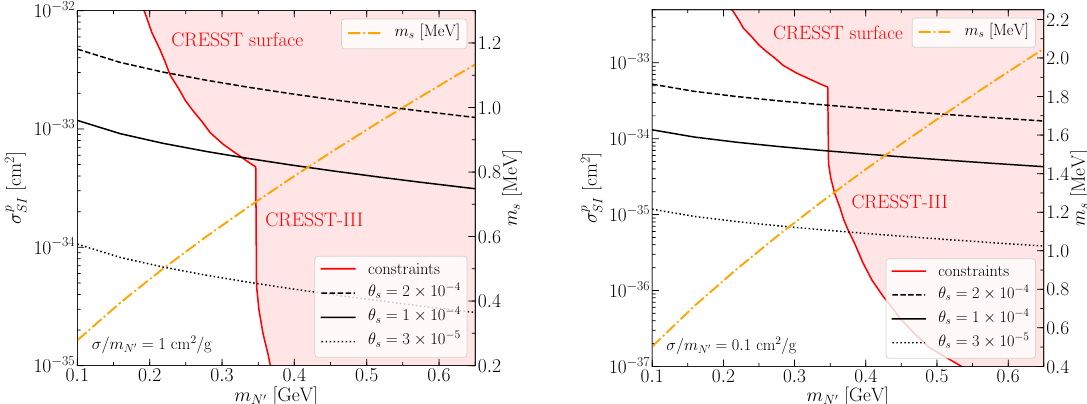
Figure 8 . Predicted spin-independent cross section for DM scattering on nucleons versus DM mass m , assuming approximately symmetric DM with a self-interaction cross section of (cid:27)=m N 0 = 1 cm 2 /g (left) or 0.1 cm 2 /g (right), for three choices of (cid:18) envelope of experimental constraints (with the exception of DarkSide-50) copied from ref. [116] (solid red). Dash-dotted curve shows the singlet mass m